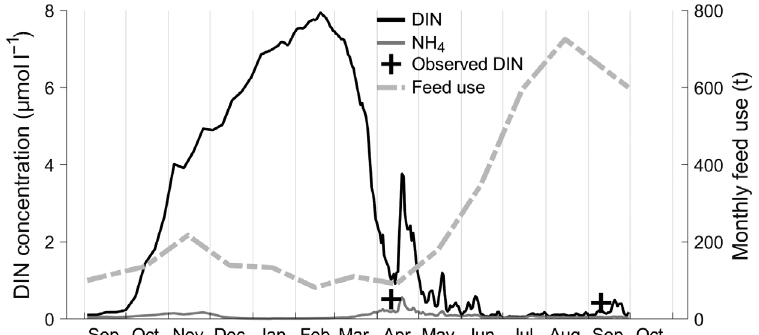
Fig. 2. Time series of observed and simulated background depth-inte- grated (0−10 m) dissolved inorganic nitrogen (DIN = NO 3− + NH 4+ ) and NH 4+ concentrations at Flåtegrunnen from September 2012 to September 2013 based on re sults from the numerical model. Monthly feed use for the farm is also shown with a period of food exclusion between 12:00 and 14:30 h. Approximately 60% of the feed was supplied in the morning period and 40% in the afternoon.